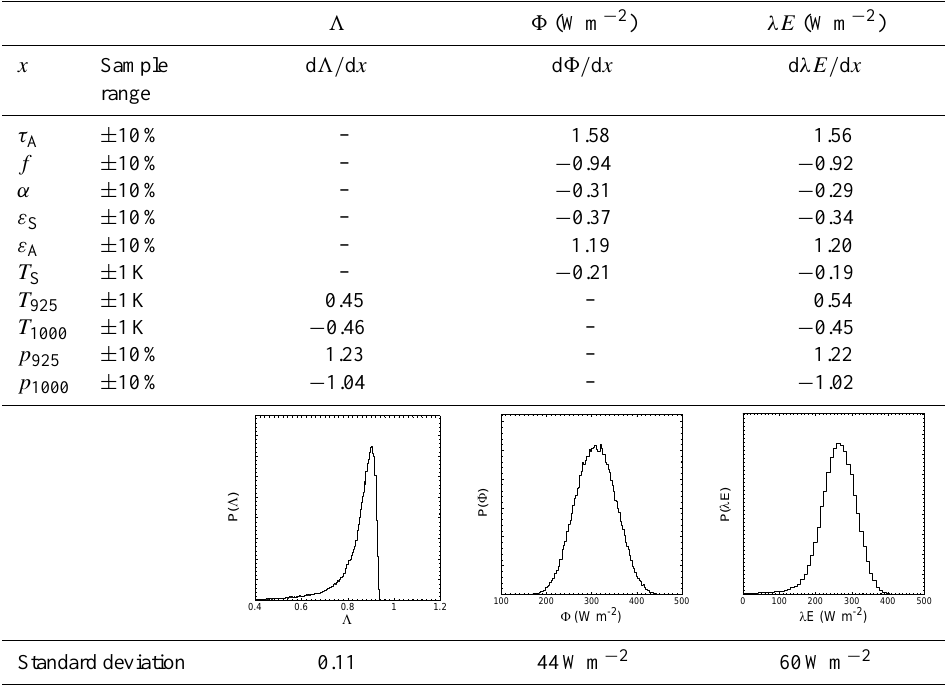
Table 2. Sensitivity analysis results of Λ, Φ and λE. The forcing data are taken for mid- summer, Southern Great Plains, US. Sensitivities are locally linear averaged across the ensemble response and expressed as dimensionless relative changes. Only absolute sensitivities > 0.1 are shown. N = 10 5 realisations.